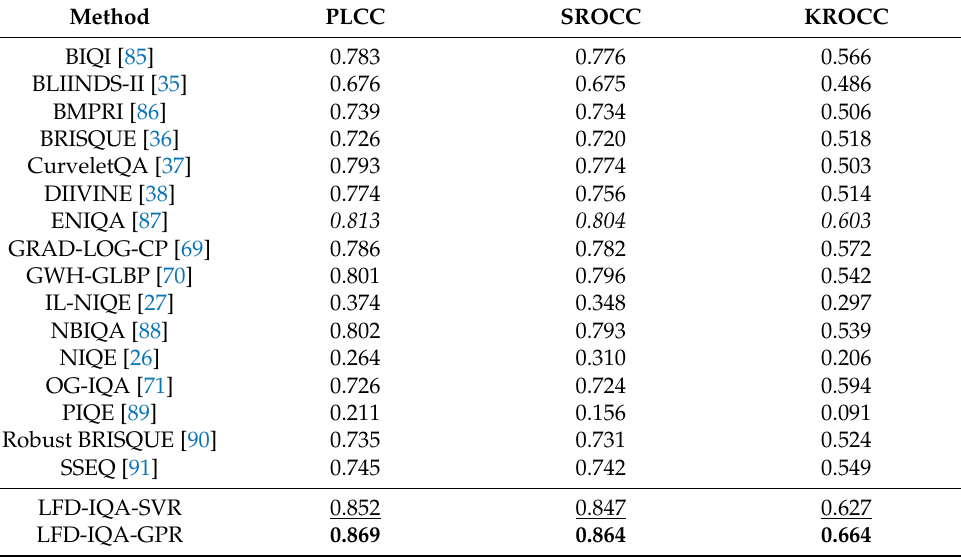
Table 3. Comparison to the state-of-the-art on SPAQ [23] database. Median PLCC, SROCC, and KROCC values were measured over 100 random train-test splits. The best results are typed in bold, the second best results are underlined, and the third best results are typed in